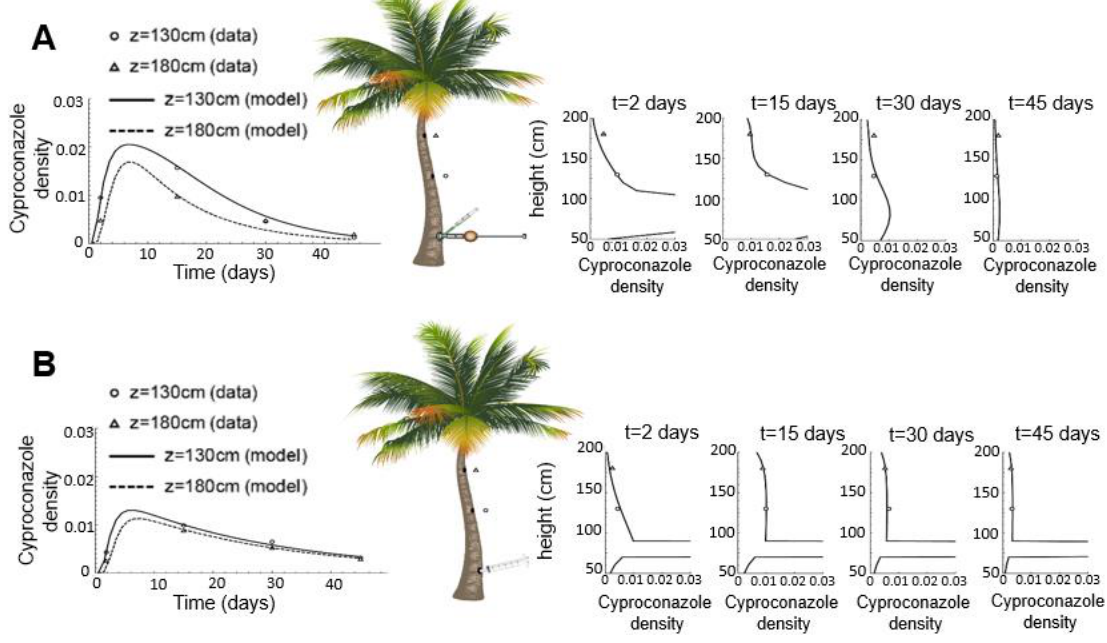
Figure 1. “ Stem Model” simulations fitted to plant average data using the pressurized ( A ) and nonpressurized ( B ) methods. Triangles and circles represent the results collected in the field, and lines represent the concentrations predicted by the model. On the left , graphs show the cyproconazole concentration over time at 130 cm and 180 cm above the ground. On the right , graphs show the cyproconazole concentration profile along the stem at days 2, 15, 30, and 45 after application.